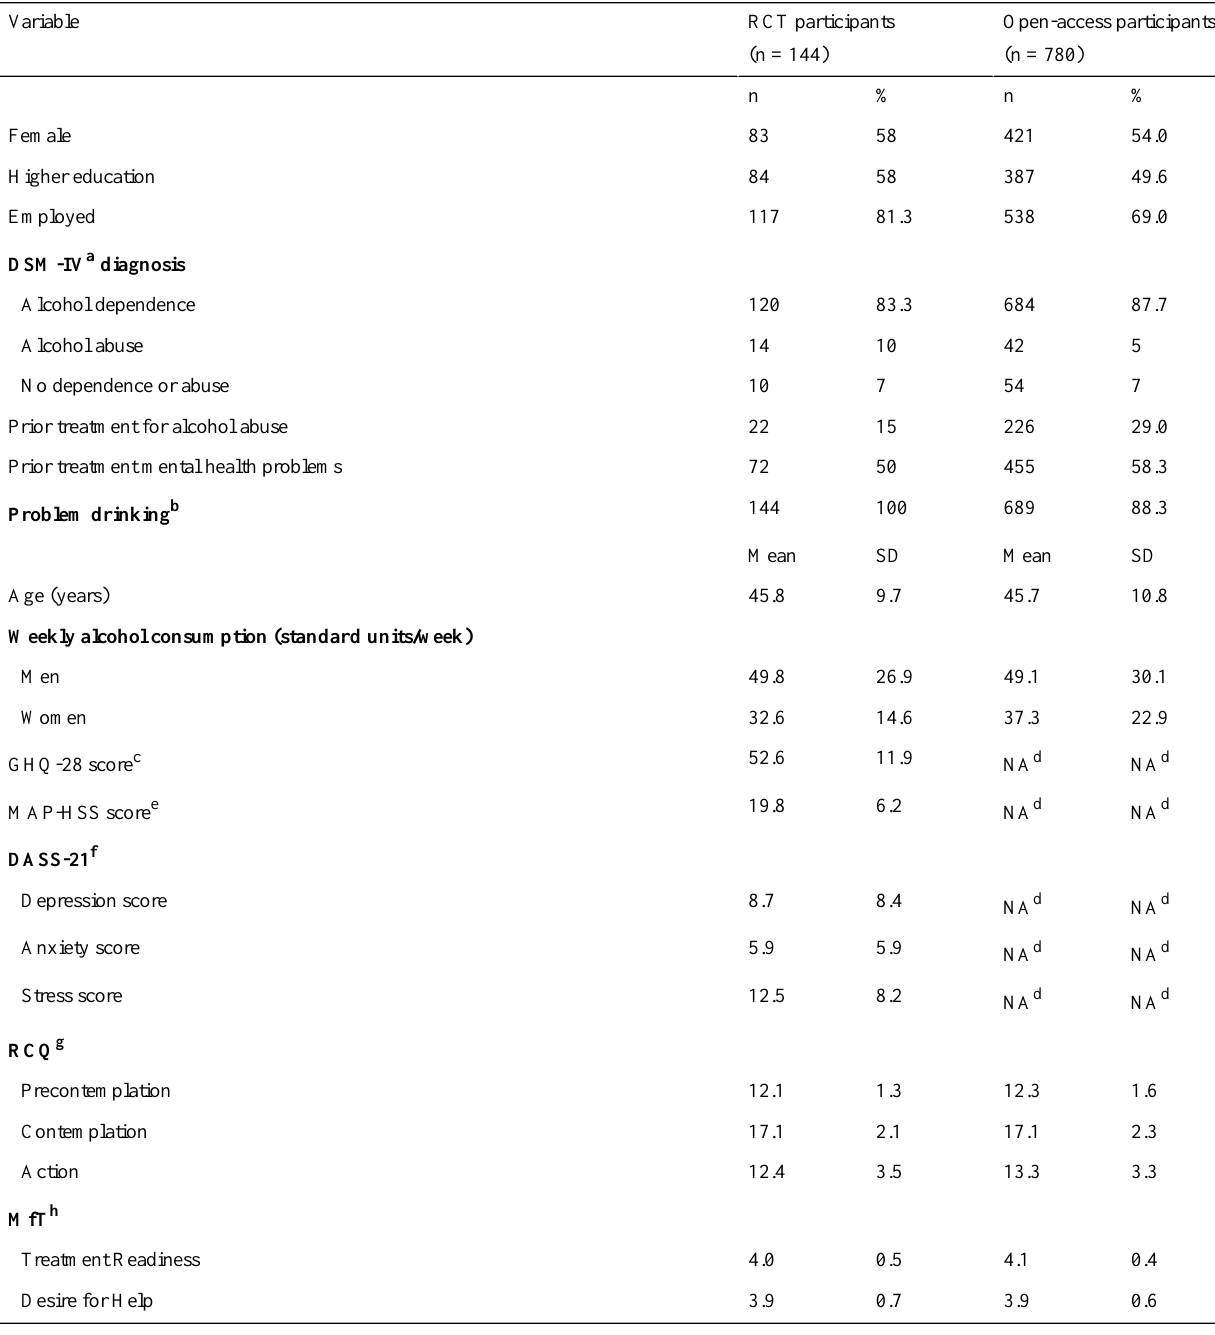
Table 1. Characteristics of participants in the randomized controlled trial (RCT) and open-access